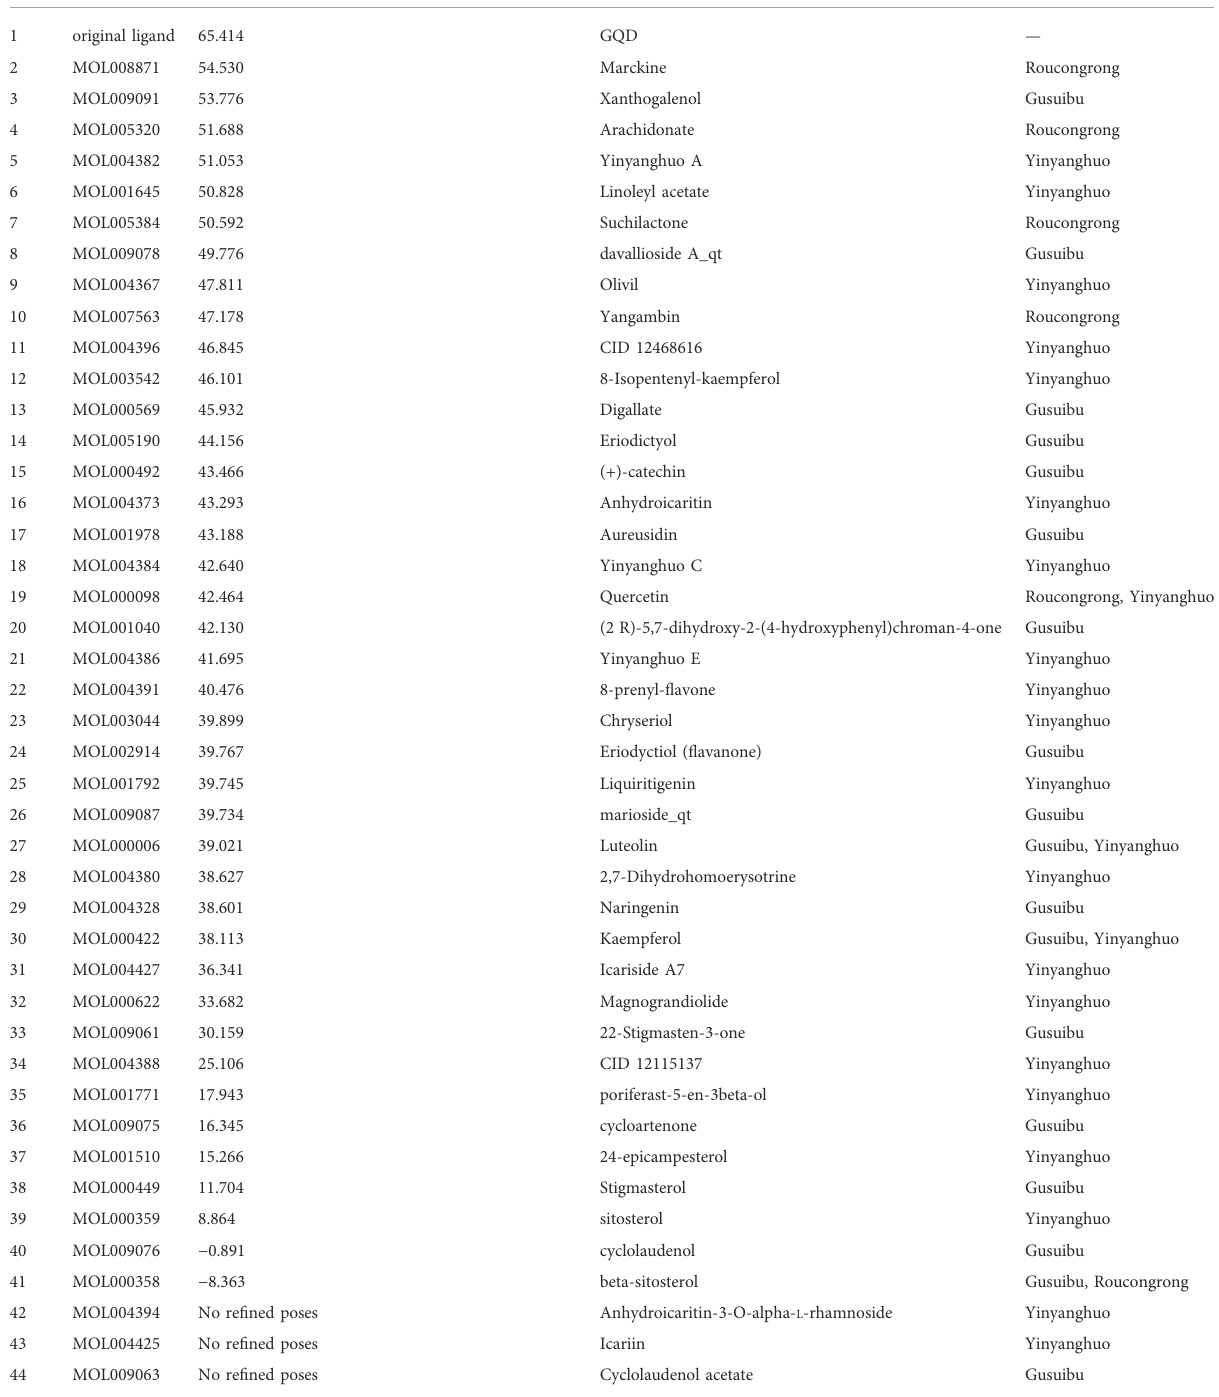
TABLE 4 ESR1 molecular docking